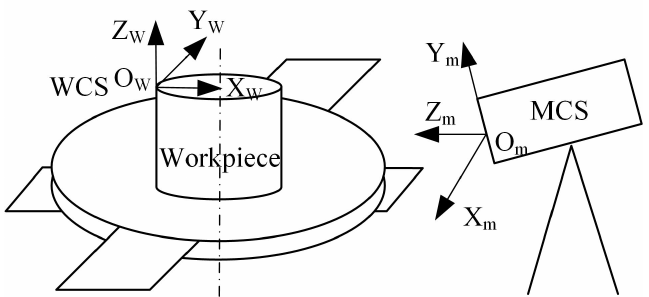
Figure 10. The measurement process of D M